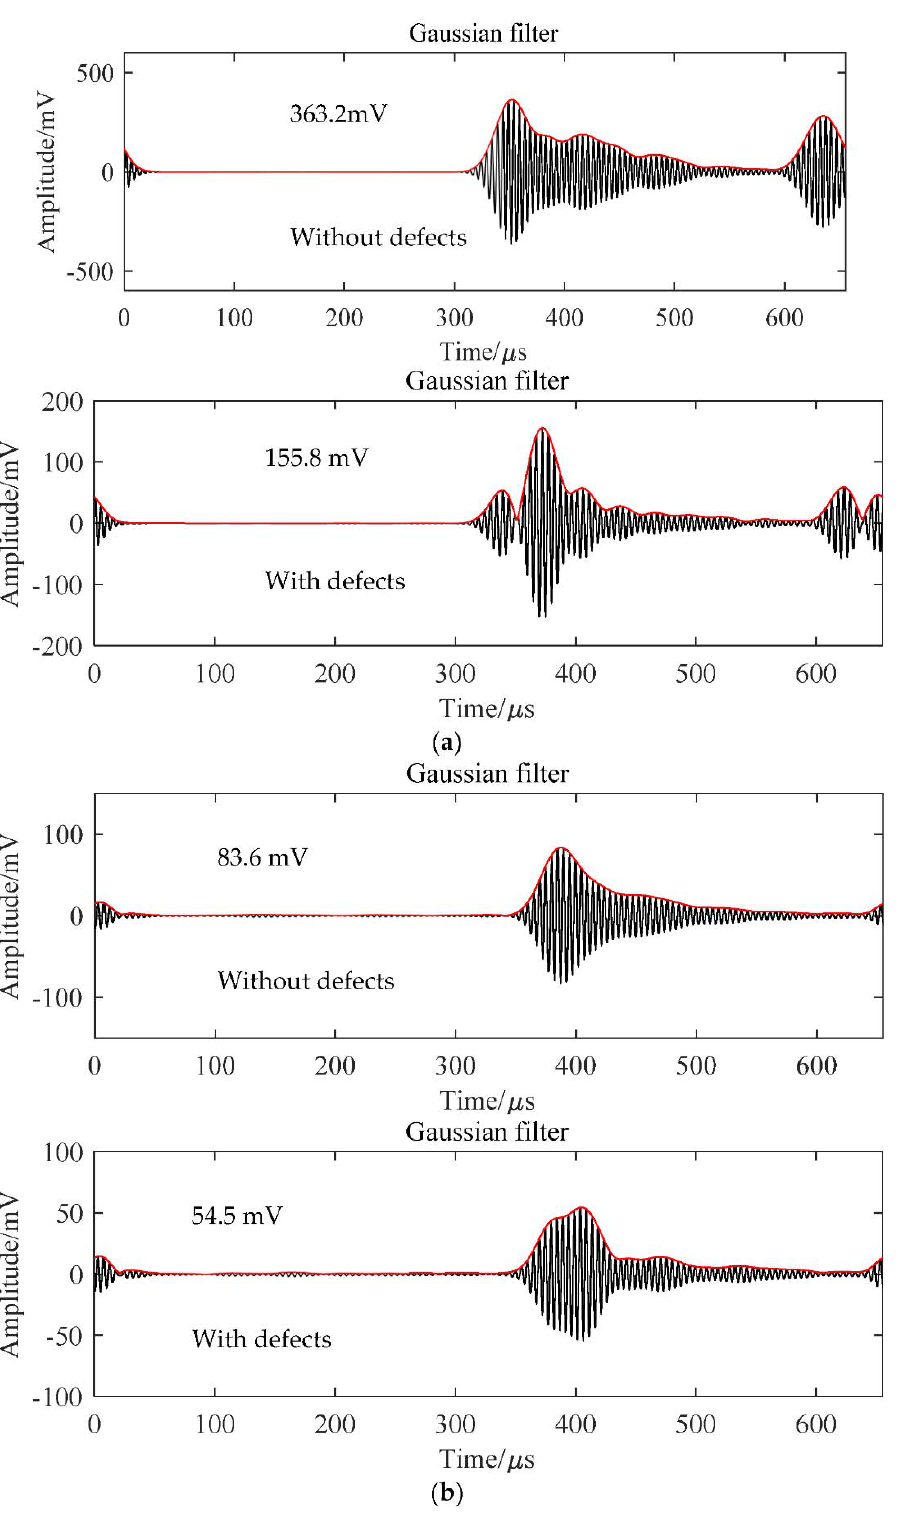
Figure 8. Time–domain filtered and enveloped signal of ( a ) PVC foam, ( b ) CFRP plates with or without defects.